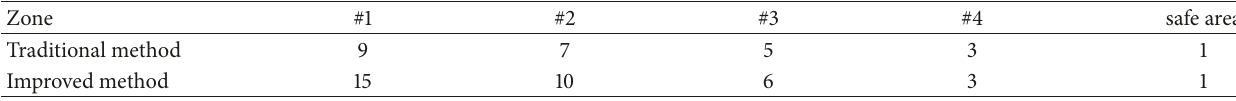
Table 9: Weight coefficient of zone risk level.